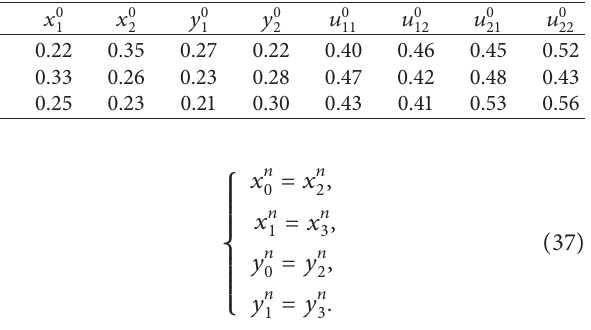
, x n , y n ,y n ,u n , u n , u n ,u n . 1 2 1 2 11 12 21 22